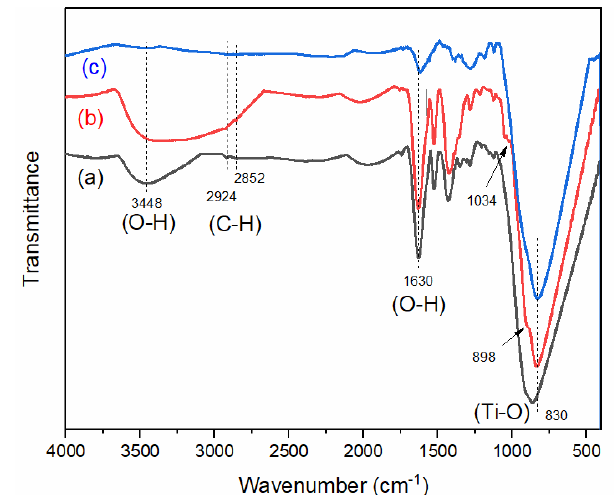
Fig. 2. FTIR spectra of (a) N ‐TiO 2 , (b) N ‐TiO 2 /C, and (c) N ‐TiO 2 /C(500) materials.